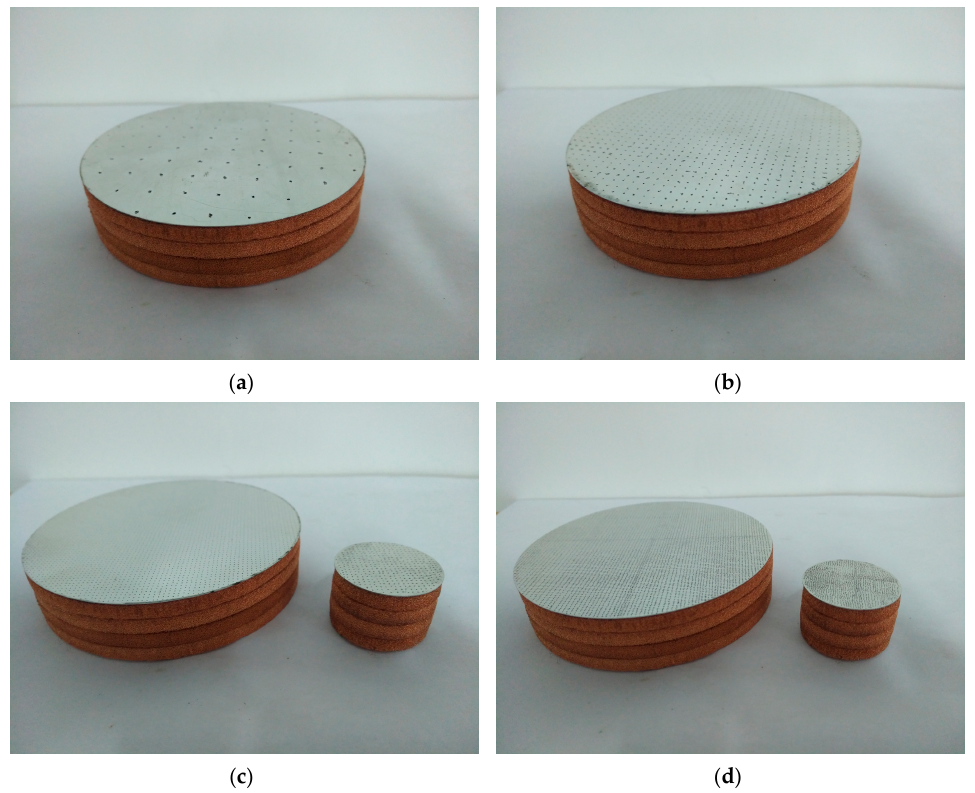
Figure 11. The composite sound-absorbing structures for improving the sound absorption performance of the porous metal with variable target frequency ranges. ( a ) Optimal structure for 100–1000 Hz; ( b ) optimal structure for 100–2000 Hz; ( c ) optimal structure for 100–3000 Hz; ( d ) optimal structure for 100–4000 Hz.